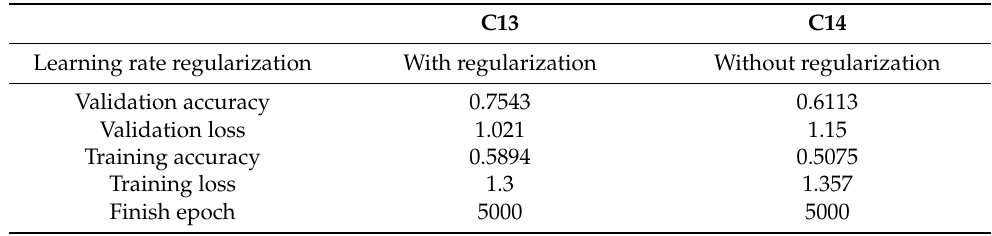
Table 6. Learning rate regularization results.